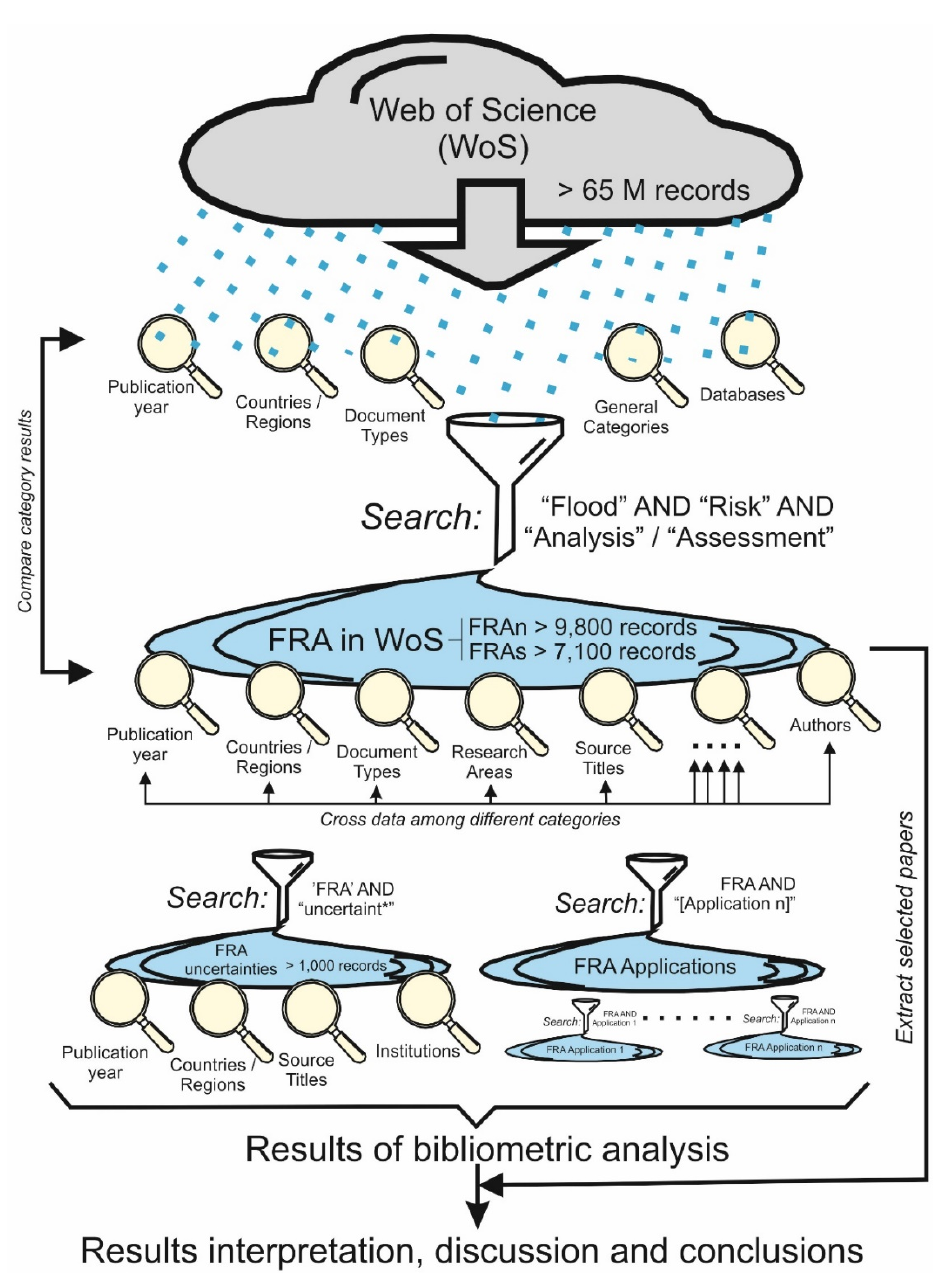
Figure 1. General methodological scheme from the data sources (Web of Science (WoS) databases) to final conclusions, throughout the different bibliometric analyses (magnifying glasses), actions (in cursive letters), search criteria (funnels) and record sets (blue pools).